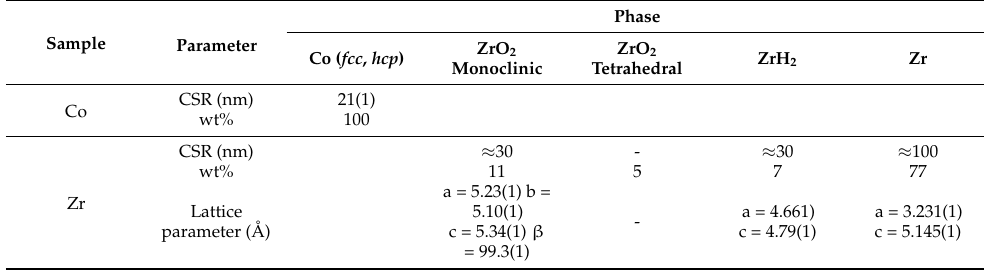
Table 2. Structural parameters and phase compositions of the initial Co and Zr